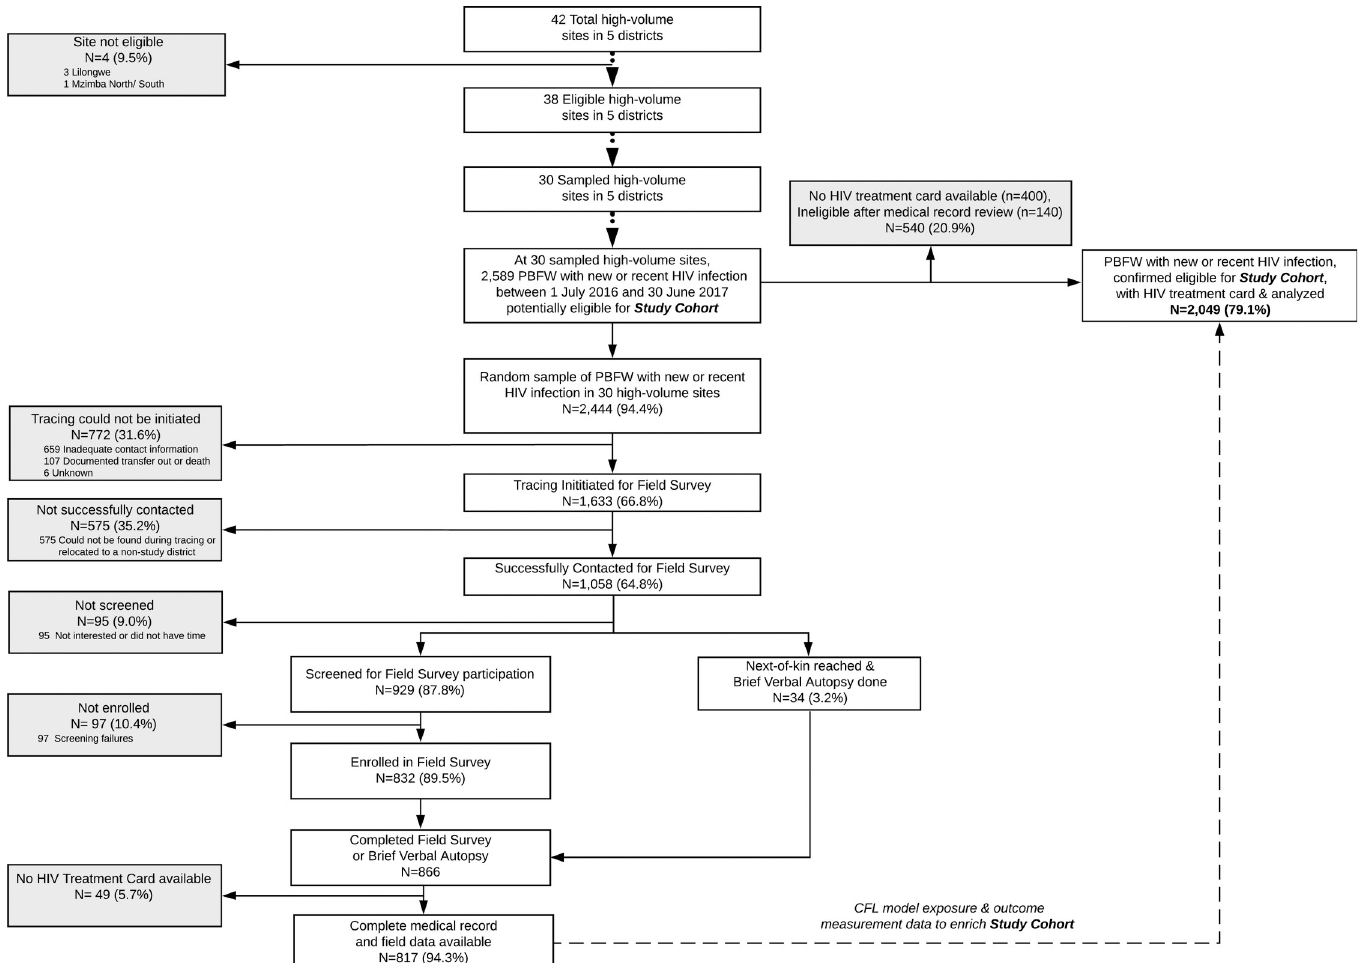
Fig 1. Participant flow through the study. CFL AU : AbbreviationlistshavebeencompiledforthoseusedinFigs 1 (cid:0) 4 : Pleaseverifythatallentriesarecorrect : , community-facility linkage; PBFW, pregnant and breastfeeding women.